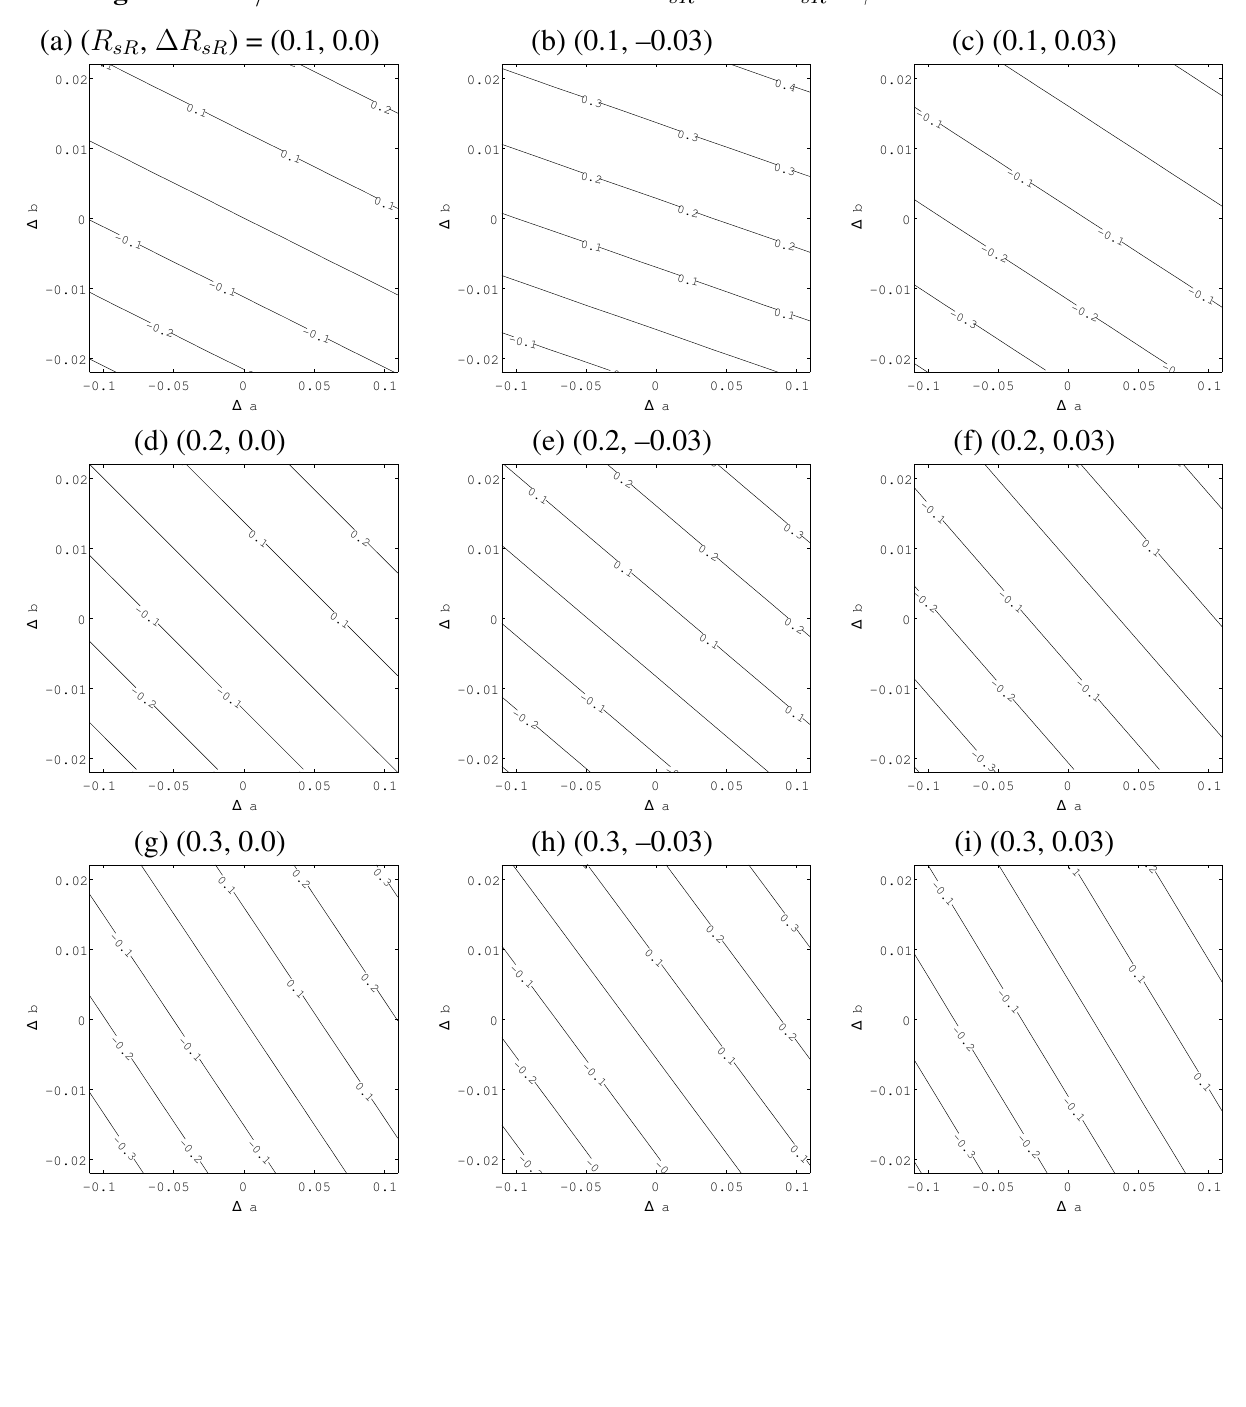
Figure 5. ∆ V=V for the nine combinations of R